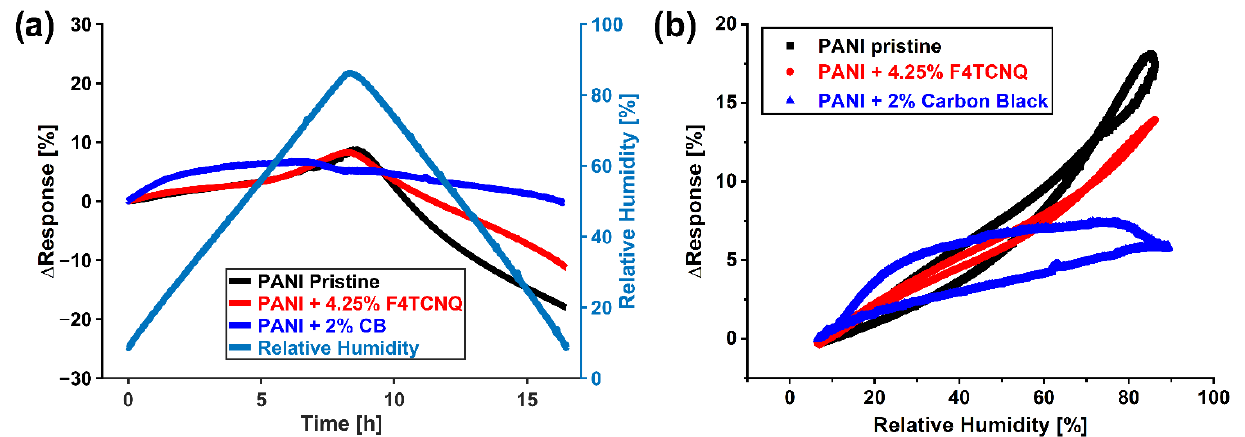
Figure 6. ( a ) Baseline changes of pristine (black), F4TCNQ-doped (red), and carbon black-doped (blue) sensors when exposed to a gradient of environmental humidity measured in a liquid calibration unit and ( b ) resulting hysteresis curves for the respective sensors.